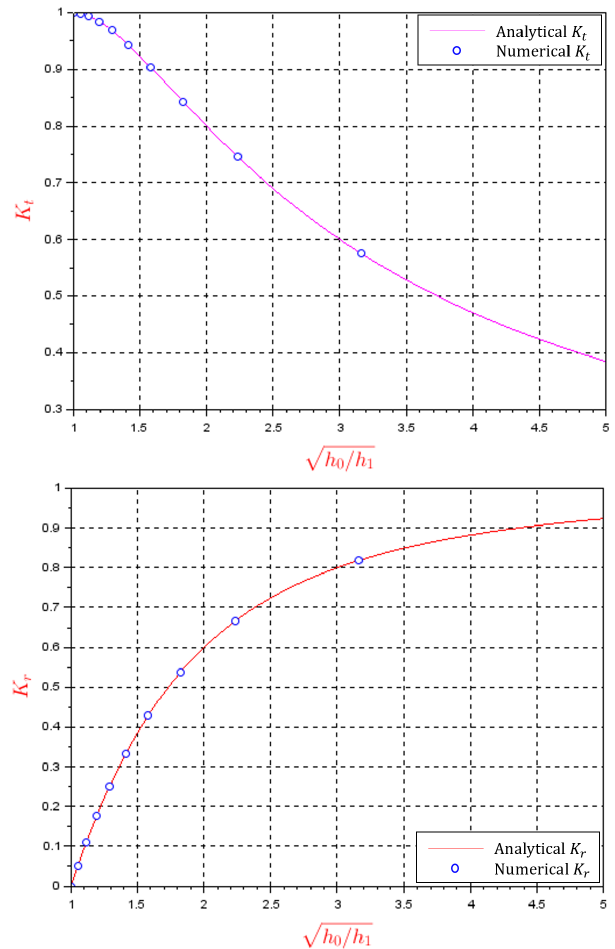
Figure 8. Comparison between numerical results and analytical solutions for K t ( Upper ) and K r ( Lower ) with h 0 = 10